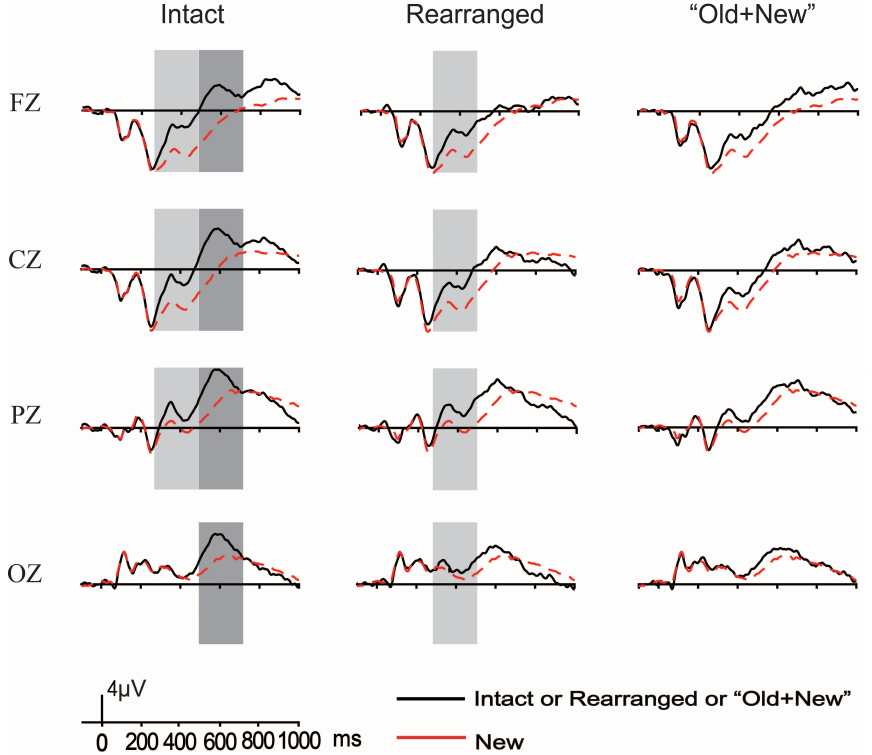
Figure 4. The grand-average ERP waveforms elicited by correctly rejected new pairs with those of correctly identified intact, rearranged, and “old + new” pairs of thematic relations, and the boxes mark the reliable FN400 and LPC.